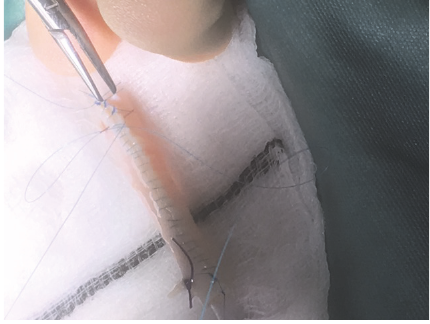
Figure 2: Aortic patch over Nelaton 8 ch catheter.